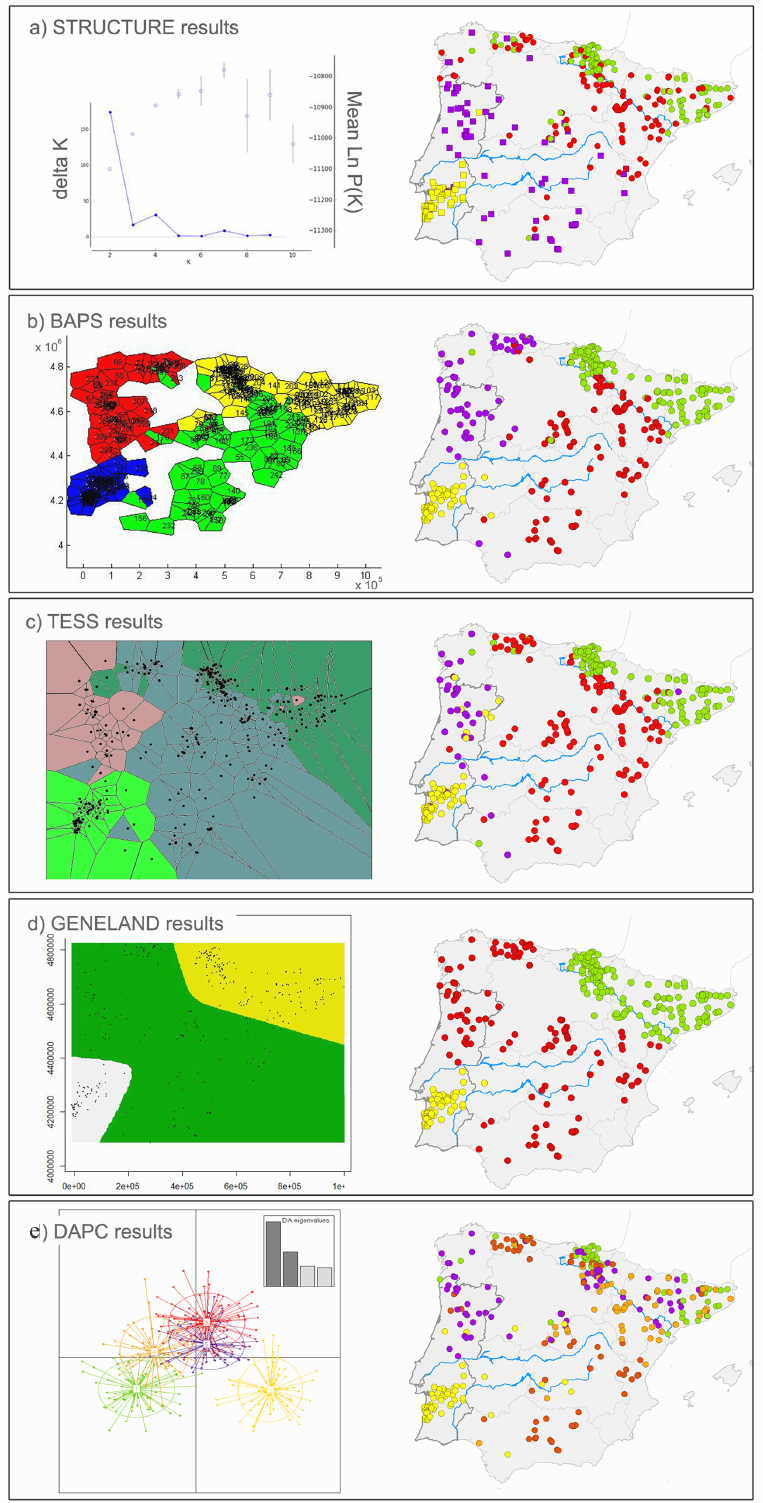
Fig 3. Map of the study area showing the results of the Bayesian clustering algorithms and the DAPC analysis. Individuals are represented by dots and coloured to reflect the cluster they were assigned to with the highest membership coefficient in each analysis. The Tagus, Ebro and Guadiana rivers are